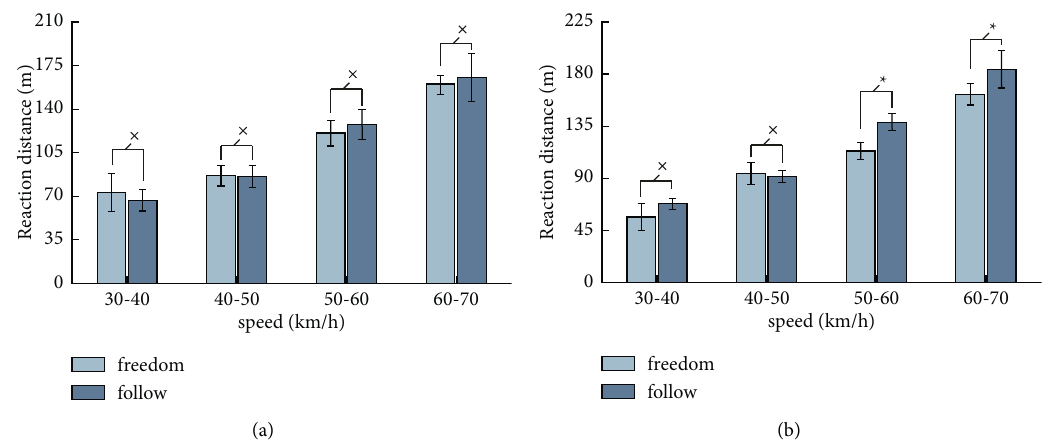
Figure 9: ANOVA results for traffic state on the first reaction distance. (a) Low density; (b) high